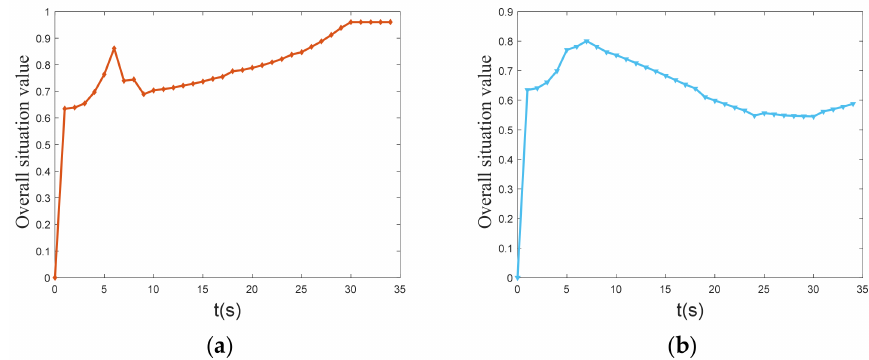
Figure 10. Overall situation value change curve. ( a ) UCAV; ( b ) enemy.